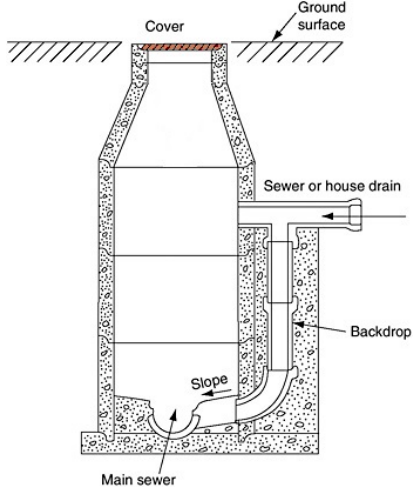
Figure 2. A typical manhole collection well.